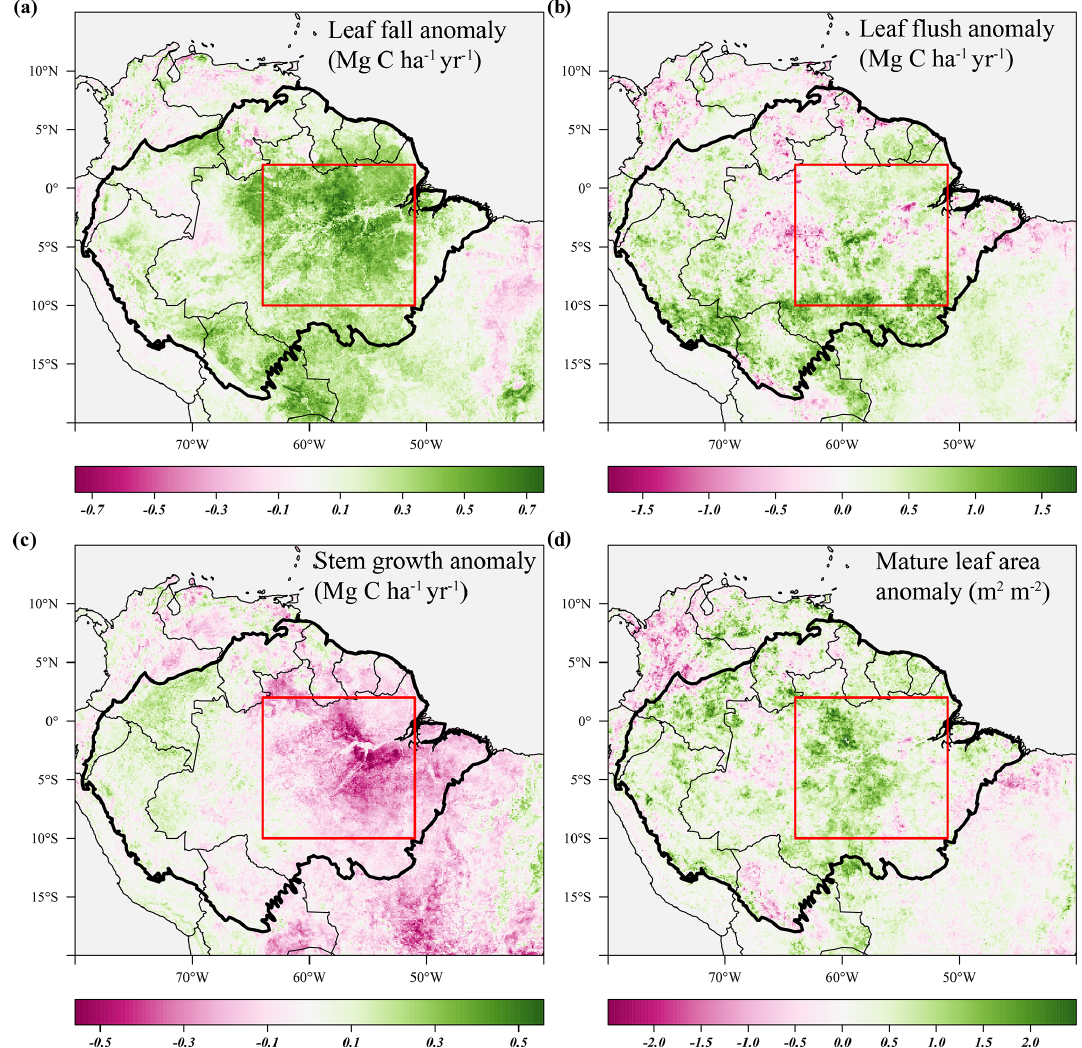
Figure 3. Average anomalies in leaf fall, leaf flushing, stem growth and mature leaf area during the 2015 drought (August 2015–January 2016) compared to their long-term averages (1982–2019). Leaf fall (a) and stem growth (c) were directly retrieved from the long-term monthly model estimates. Leaf flush (b) was calculated from monthly predicted leaf fall (a) and changes in LAI (Eq. 1). Mature leaf area (d) is the sum of new leaf area flushed in the previous 2 to 5 months (Eq. 2). Country borders and the extent of the Amazon basin are marked by thin and thick black lines, respectively. The red rectangle delineates the drought area for which further results are